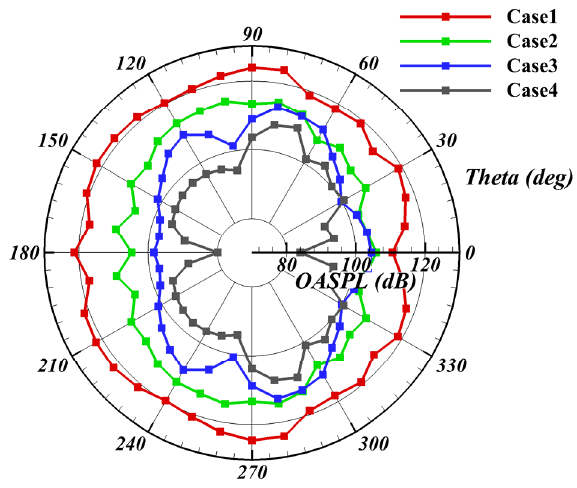
Figure 21. The overall sound pressure level.